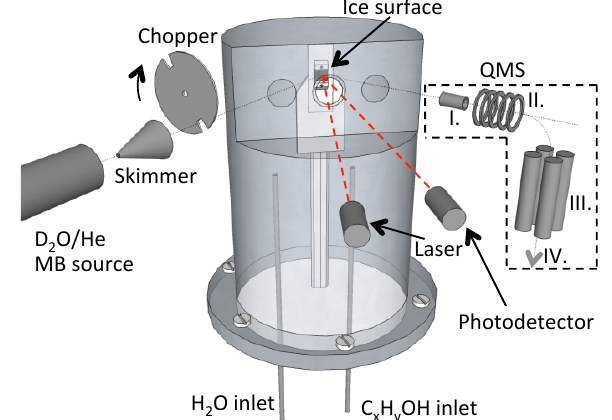
Fig. 1. Schematic view of the inner-workings of the molecular beam apparatus used in the present study. Molecules leaving the surface enter the QMS and are I. ionized before a II. series of lenses focuses and accelerates them through 90 ◦ before entering the III. quadrupole rods, which focus the IV. selected ions onto the